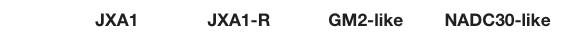
TABLE 3 | Inhibitory activity of PNS against PRRSV infection in Marc-145 cells. PRRSV